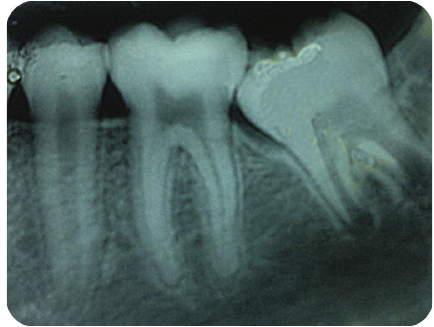
Figure 2: Intraoral periapical radiograph showing permanent mandibular second molar locked beneath first permanent molar.